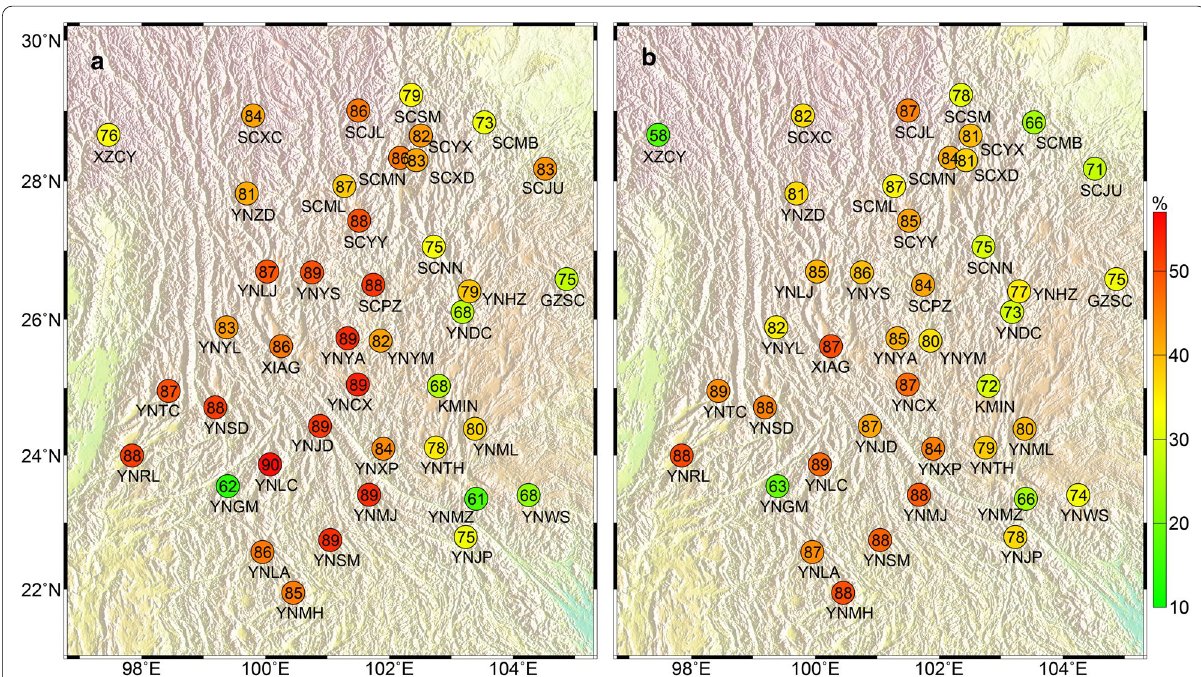
Fig. 6 Correlation coefficient (CC) and root mean square (RMS) reduction at 41 stations. a Global positioning system (GPS)/gravity recovery and climate experiment (GRACE); b GPS/surface loading model (SLM). The color of the circle represents the RMS reduction, and the number in the circle is CC ×